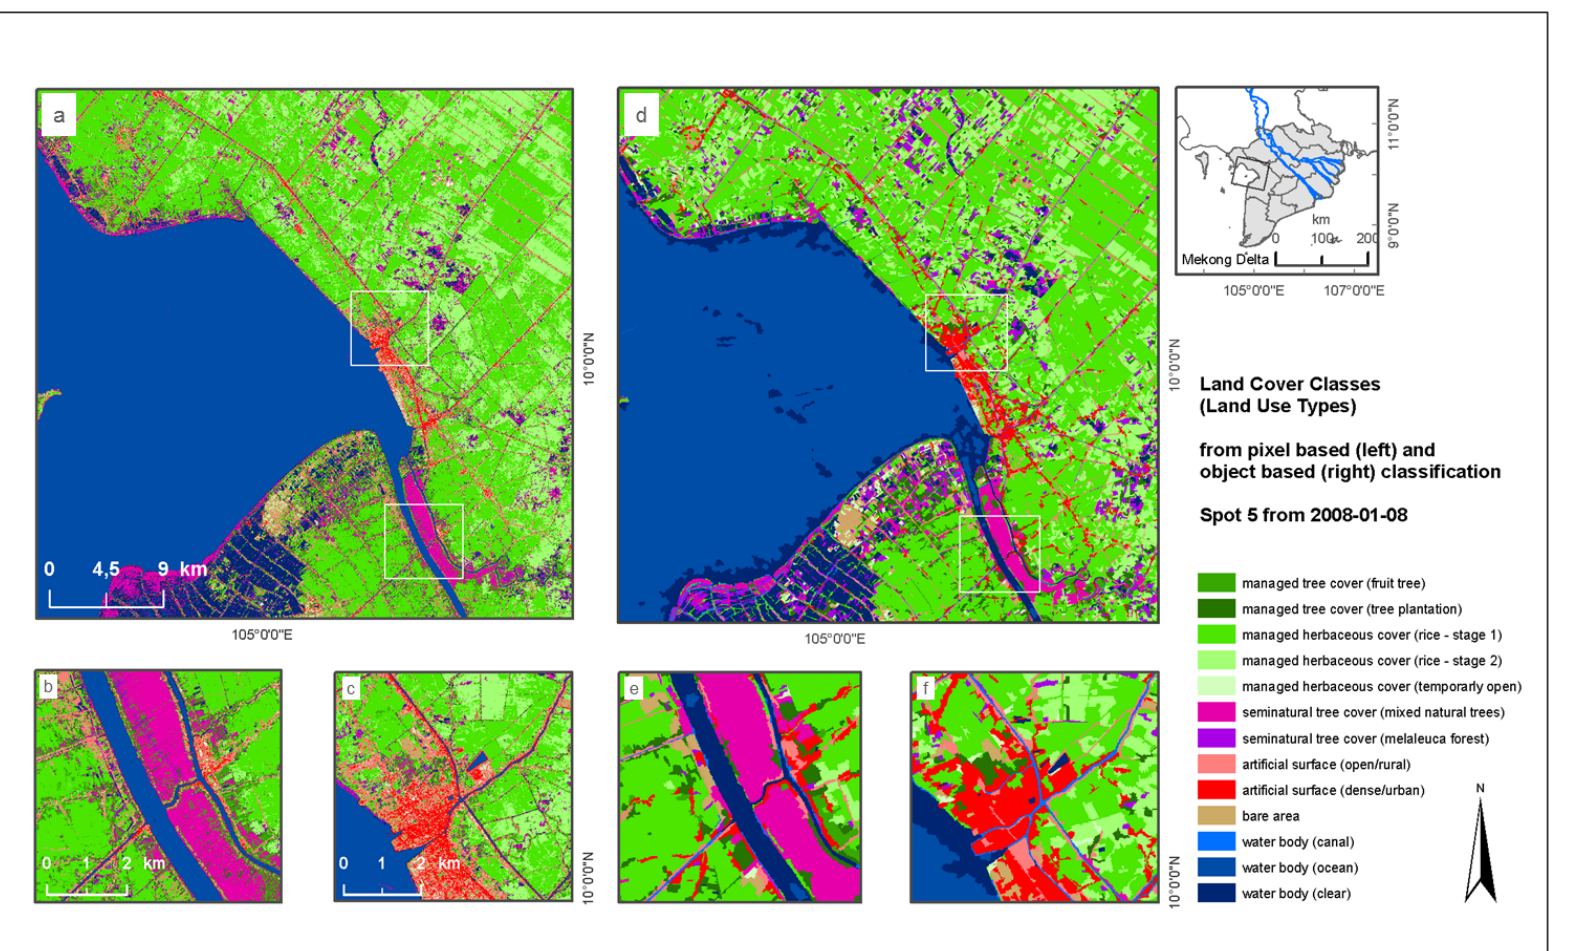
Figure 4. Classification result of TWOPAC run with SPOT5 dataset (2008-01-08) from the western coast of the Mekong Delta—subset of pixel-based result (( a ) detail on rural area and natural tree area in ( b ); detail on urban area ( c )); subset of object-based result (( d ) details in ( e , f